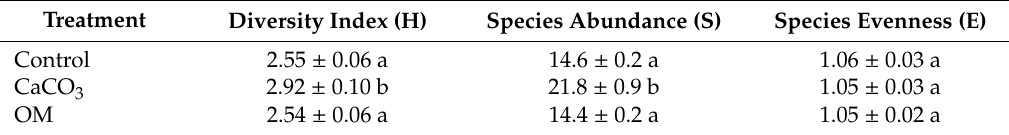
Figure 3. Denaturing Gradient Gel Electrophoresis profiles of arbuscular mycorrhizal fungal community in the soils of P. natatum and the corresponding clustering analysis. CaCO 3 , liming; OM, plant residue incorporation. Table 4. Influences of liming (CaCO 3 ) or plant residue incorporation (OM) on arbuscular mycorrhizal fungal community structure in the soil of P. natatum . Data followed by the same letter are not significantly different (Tukey’s post hoc test, P = 0.05, n = 5).